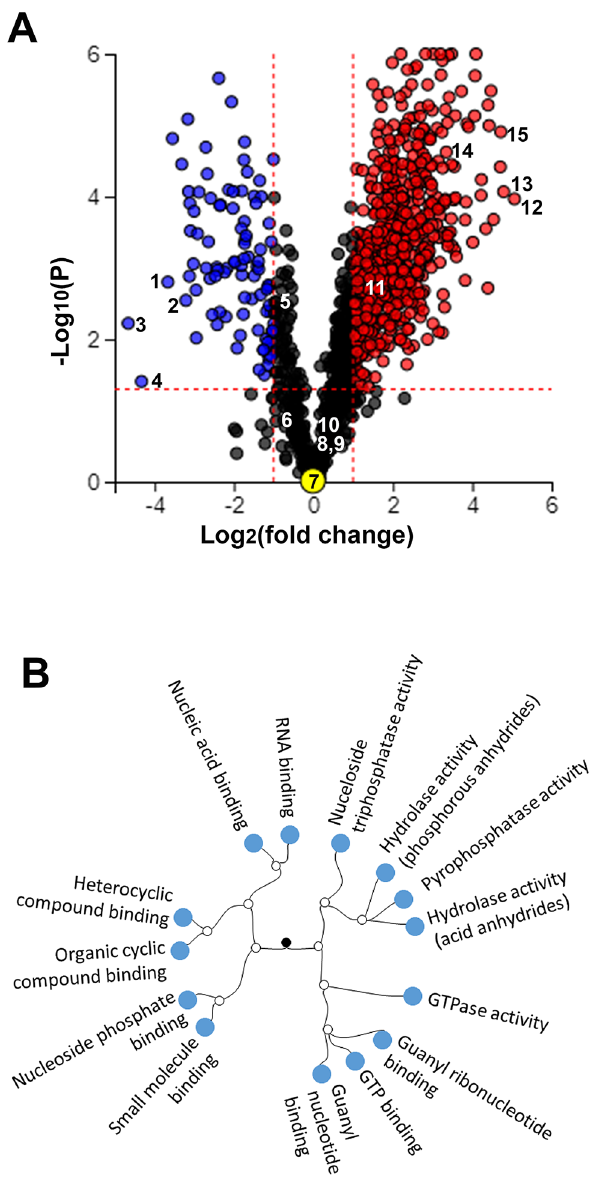
Figure 2. Human iPSC-RPE polarized secretome is more apical than basolateral. ( A ) Volcano plot from data set 2 showing proteins with at least twofold change and p < 0.05, in blue (more basolateral) or red (more apical). N = 4 biologic replicates. The 3 most differentially secreted proteins in both the apical and basolateral compartments, as well as proteins of interest as described in the results section, are labeled by number on the graph: 1. RNF7, 2. TIMP3, 3. UBR, 4. PTPN22, 5. CFI, 6. VEGF, 7. C1QTNF5, 8. PTN, 9. HTRA1, 10. CFH, 11. PEDF, 12. RPL12, 13. HMGN2, 14. CRYAB, 15. PSMA1. ( B ) Dendrogram from data set 2 showing molecular functions that were differentially represented in apical vs basolateral samples (p < 0.05, adjusted for false discovery rate). Analysis was performed using Advaita Bio ipathwayguide 12,13